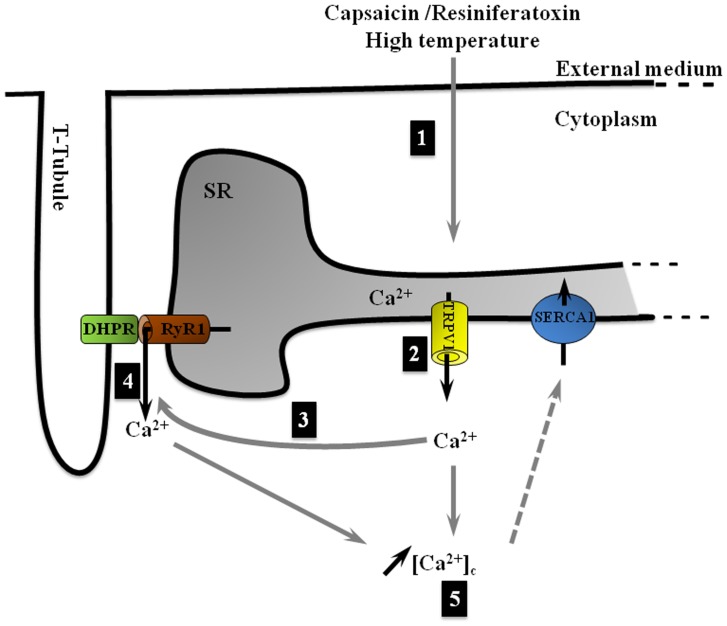
Schematic drawing of the possible TRPV1 contribution in the maintenance of Ca2+ muscle homeostasis.(1) External stimuli, such as capsaicin, resiniferatoxin or high temperature, activate TRPV1 channels located at the longitudinal SR. (2) TRPV1 channels releases Ca2+ from SR to cytoplasm. (3) This low increase in [Ca2+]c activates RyR channels (4) that in return release Ca2+ into cytoplasm increasing [Ca2+]c (5). In permanence, SERCA1 pumps continuously back Ca2+ from cytoplasm to SR and could mask TRPV1 activation in resting condition.